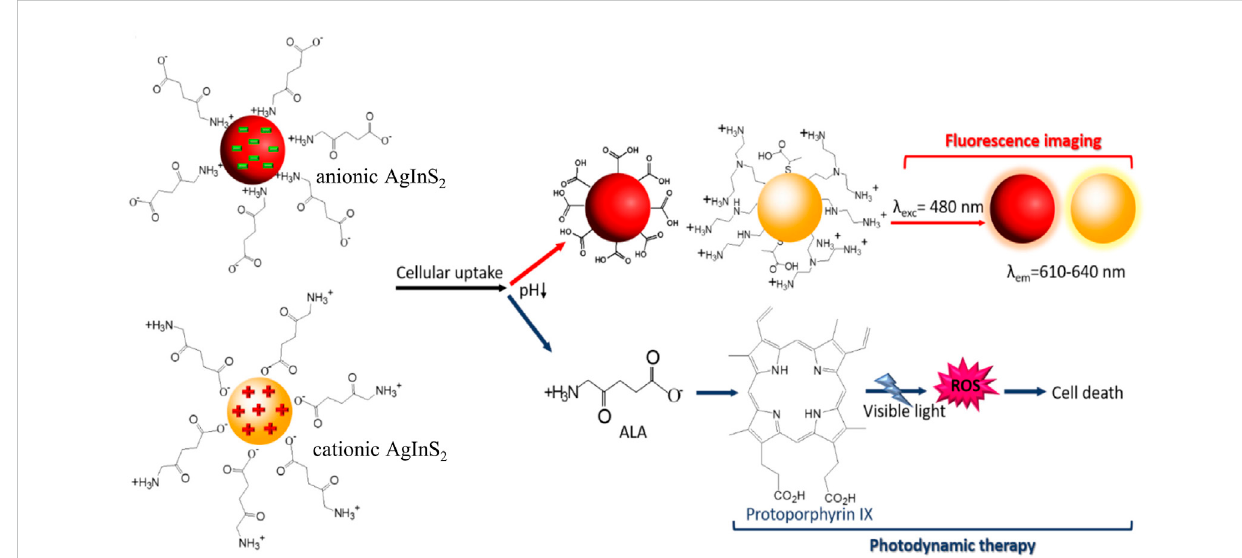
FIGURE 5 Schematic showing the design and responsive mechanism of ALA-loaded anionic and cationic AIS QDs. Adapted from ref. (Hashemkhani et al., 2022). Copyright 2022 American Chemical Society.